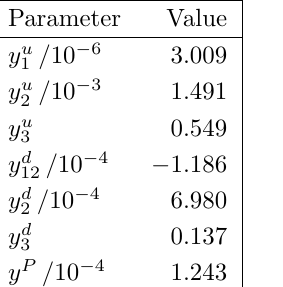
Table 4 . Best (cid:12)t input parameter values. The model has 13 real parameters: y u y P . While (cid:17) is (cid:12)xed by (cid:13)avon alignment to